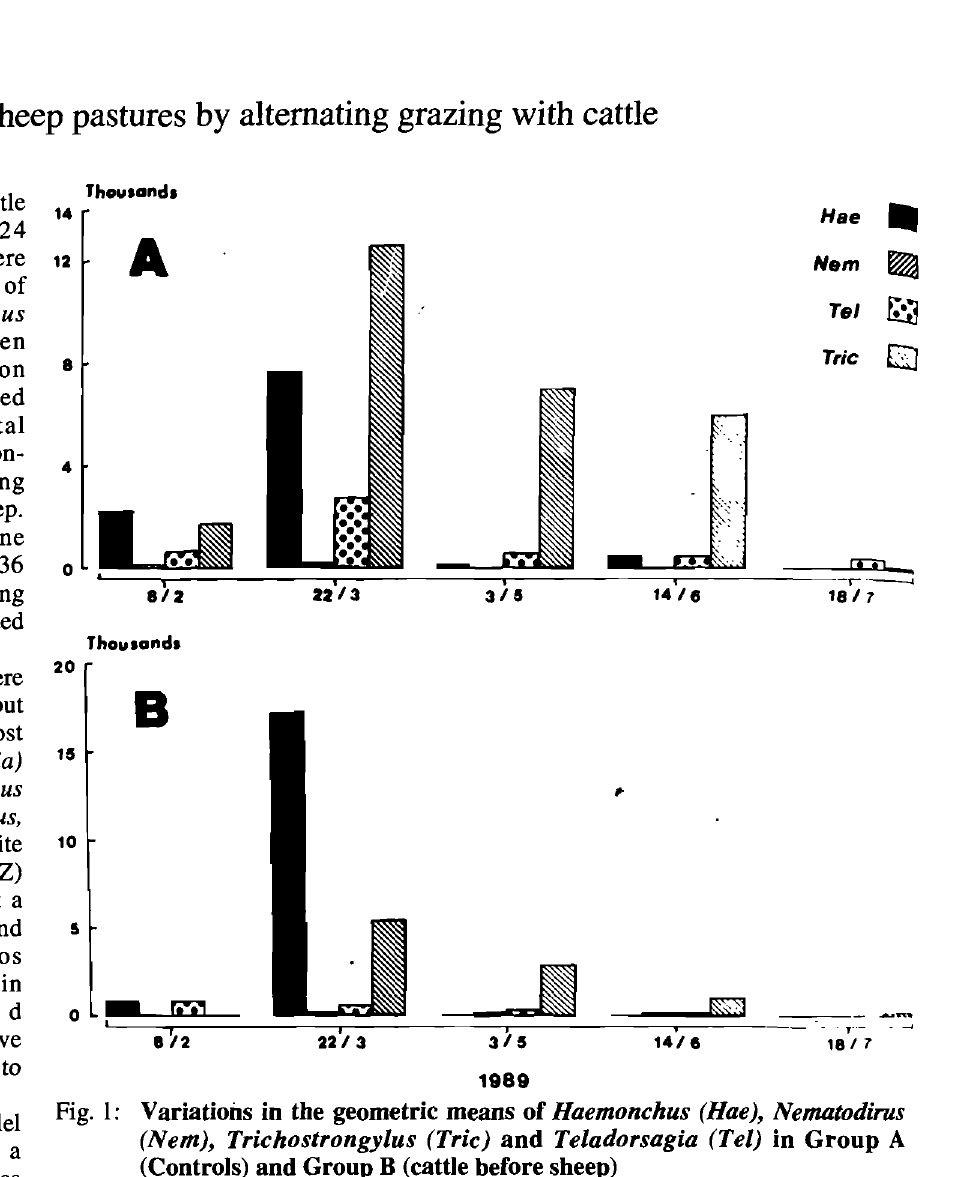
Fig. 1: Variations in the geometric means of Haemonchus (Hae), Nematodirus (Nem), Trichostrongylus (Tric) and Teladorsagia (Tel) in Group A (Controls) and Group B (cattle before sheep) phenol (DNP) (Mintic, Fisher) (10